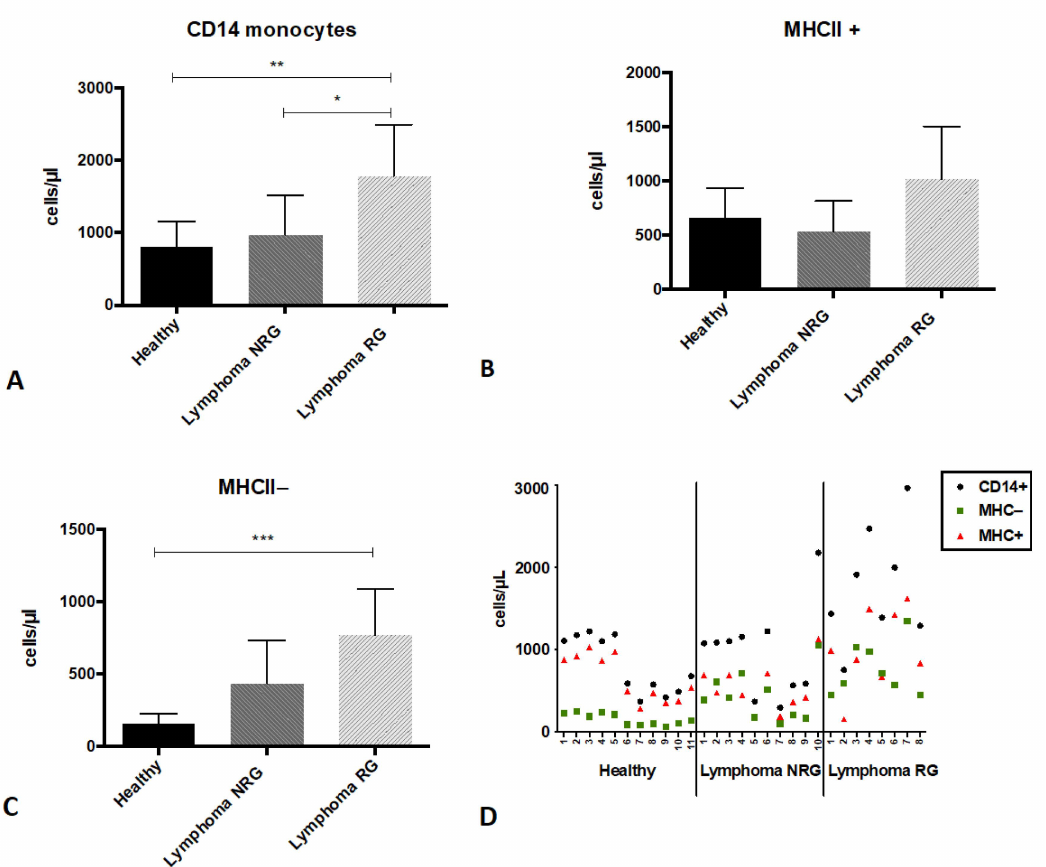
Figure 4. The number of CD14+ monocytes in the peripheral blood of healthy dogs ( n = 11) and dogs with lymphoma: not receiving any drugs (NRG, n = 10) and receiving glucocorticoids (RG, n = 8). ( A ) Total number of CD14+ monocytes per microliter of peripheral blood. The number of CD14+ cells was calculated based on their percentage in relation to all leukocytes (CD45+ cells) and white blood cell count. ( B ) The number of MHCII+ and ( C ) MHCII − monocyte subsets. Arithmetic mean ± standard deviation. Significant differences between groups: * p < 0.05, ** p ≤ 0.01, *** p ≤ 0.001 (Kruskal–Wallis and Dunn post hoc analysis). ( D ) The numbers of all evaluated cell populations in individual patients: MHCII − and MHCII+ monocytes as well as all CD14+ cell